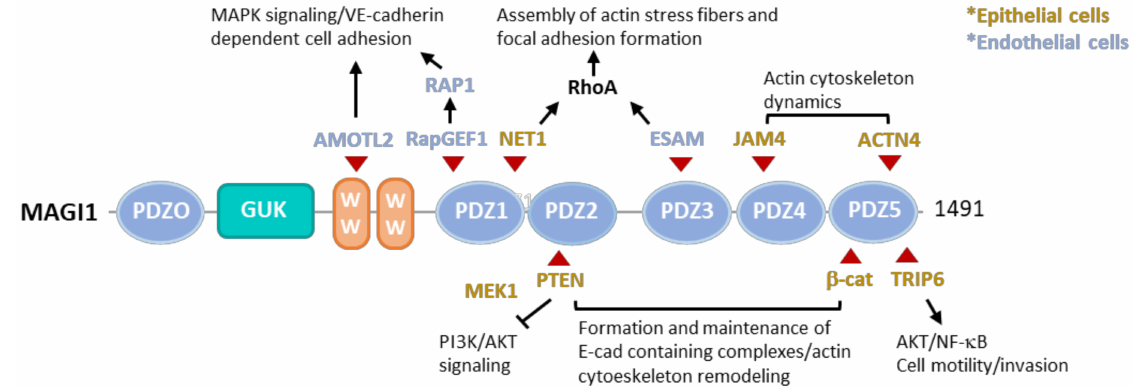
Figure 1. Schematic representation of MAGI1 domain structure and selected interacting molecules relevant for cancer and vascular biology. In endothelial cells, AMOTL2 is needed for the connection of the VE-cadherin/catenin complex to MAGI1 and actin filaments, and for transmission of forces between neighboring cells [42]. MAGI1 interacts with RapGEF1, activating Rap1, which regulates the MAPK signaling pathway and VE-cadherin-mediated cell adhesion [43]. ESAM binds MAGI1 and recruits it to cell–cell contacts [21], promoting and strengthening mature cell–cell adhesion via activation of RhoA [44]. In epithelial cells, MAGI1 interacts with NET1 [22], which in turn activates RhoA [45], leading to the assembly of actin stress fibers and focal adhesion formation [46]. MAGI1 colocalizes with E-cadherin, β -catenin, and PTEN, regulating the formation and maintenance of E-cadherin containing complexes [25,26]. MEK1 is necessary for PTEN membrane recruitment [28]. TRIP6 competes with β -catenin for the binding to the MAGI1/PTEN signalosome, destabilizing E-cadherin complexes and promoting cell motility through the regulation of AKT/NF- κ B targets [27]. At tight junctions, MAGI1 colocalizes with JAM4 [20] and α -actinin-4 [31], regulating the actin cytoskeleton dynamics. Arrows ( ↑ ) indicate activation/induction, blunt ended lines (T) indicate inhibition/blockade. RapGEP: Rap guanine nucleotide exchange factor 1; Rap1: Ras-related protein 1; MAPK: mitogen-activated protein kinase; VE-cadherin: vascular endothelial-cadherin; NET1: neuroepithelial cell transforming 1; RhoA: Ras homolog family member A; ESAM: endothelial cell adhesion molecule; AMOTL2: angiomotin like 2; PTEN: phosphatase and tensin homolog; PI3K/AKT: phosphoinositide 3-kinase/protein kinase B; TRIP6: thyroid hormone receptor interactor 6; NF- κ B: nuclear factor kappa B; ACTN4: α